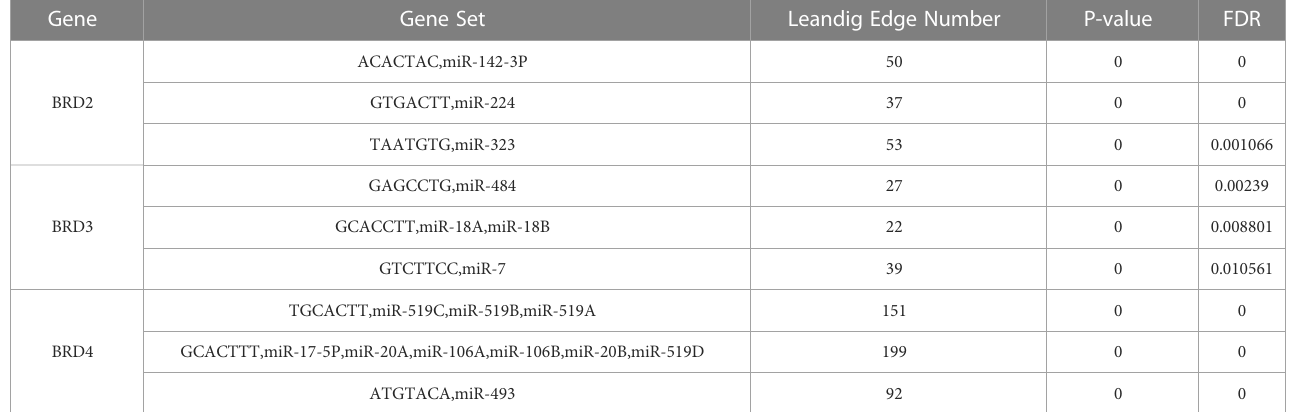
TABLE 5 The top three miRNA target of BET family in ACC